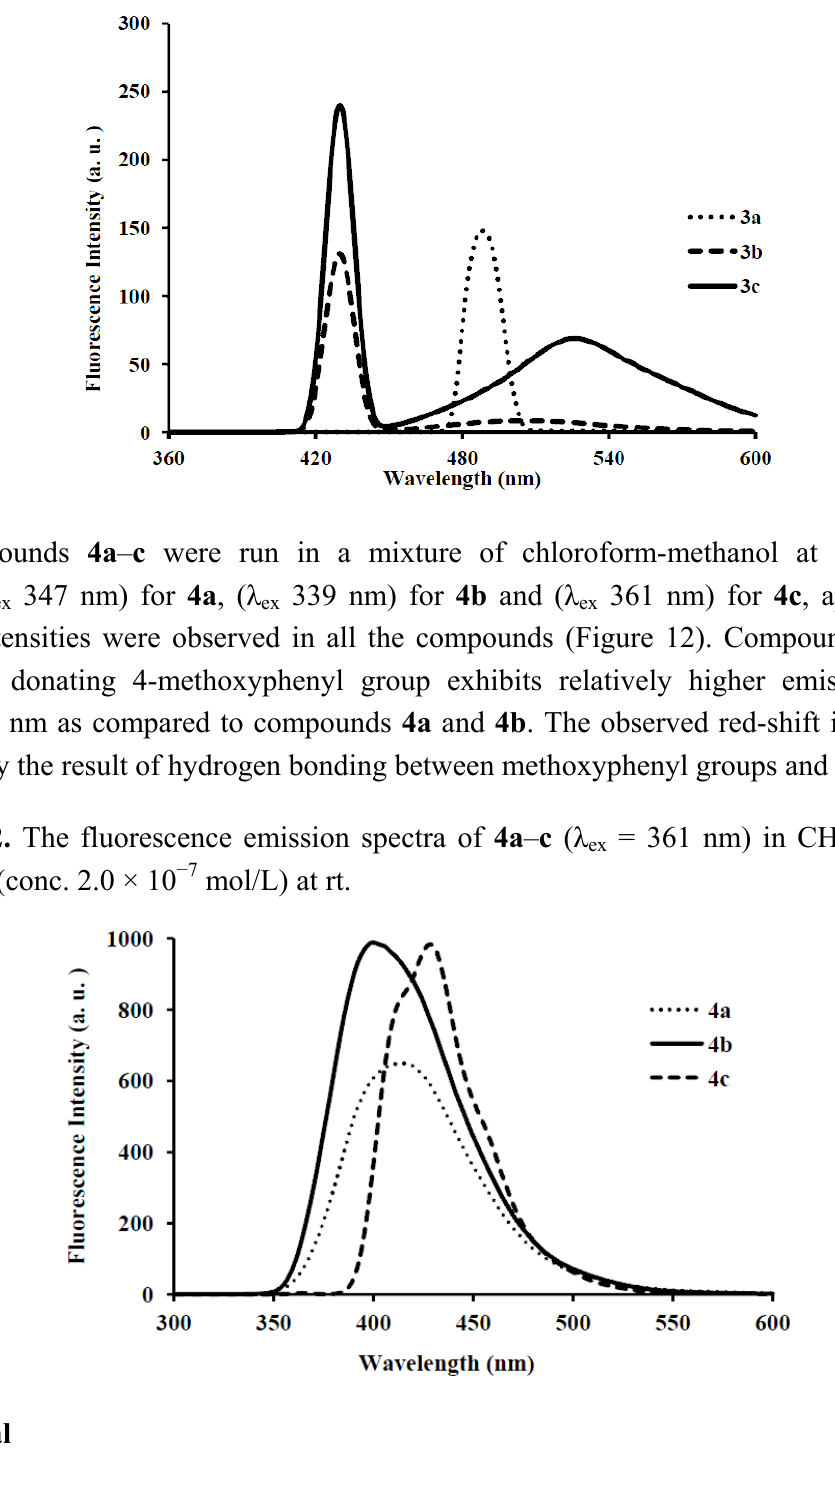
= 350 nm) in CHCl –MeOH ex 3